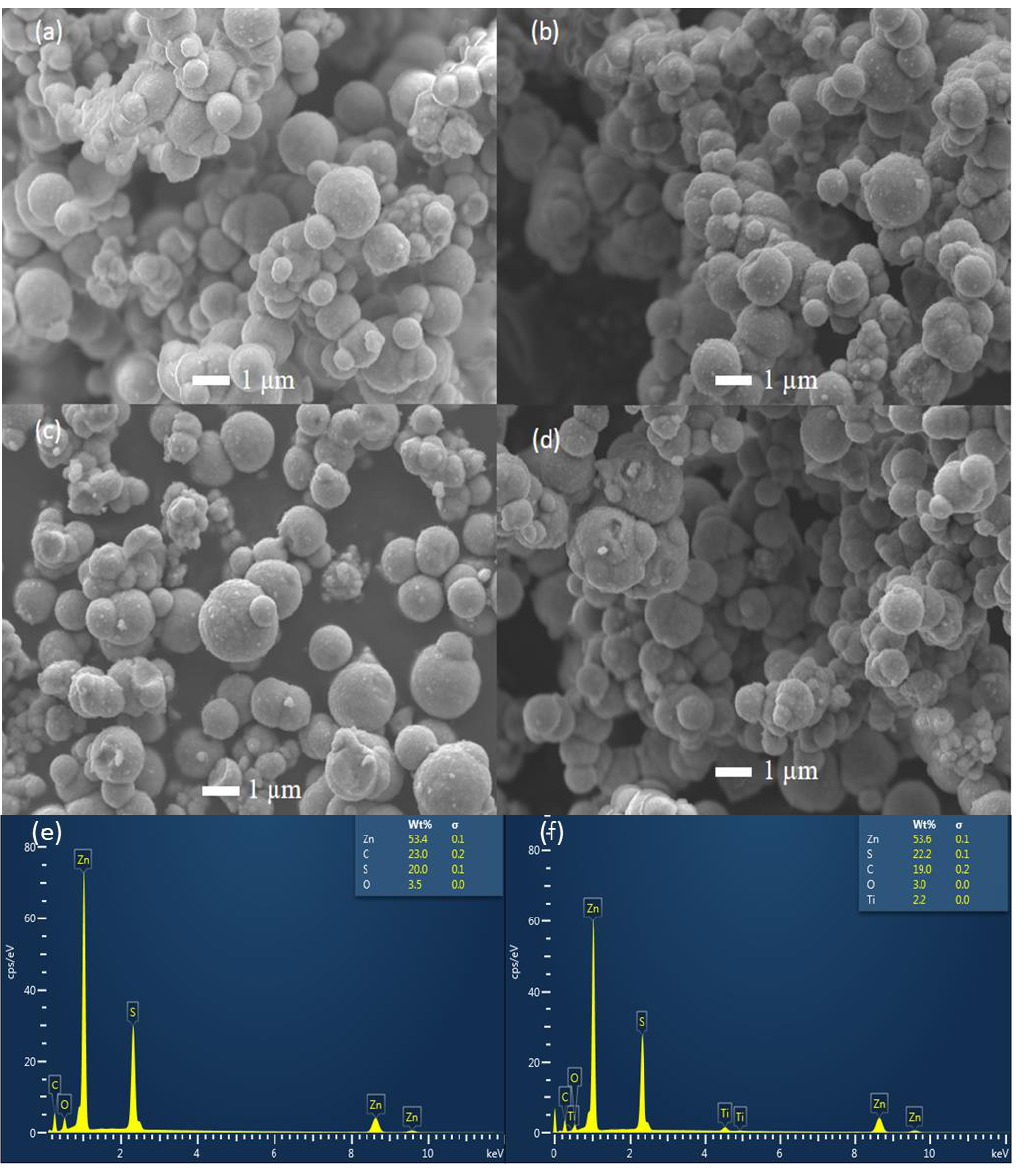
Figure 3. SEM micrographs of ( a ) undoped ZnS nanoparticles, ( b ) 0.50% Ti-doped ZnS nanoparticles, ( c ) 0.75% Ti-doped ZnS nanoparticles, ( d ) 1.00% Ti-doped ZnS nanoparticles, EDS analysis for ( e ) undoped ZnS nanoparticles, and ( f ) 1.00% Ti-doped ZnS nanoparticles.